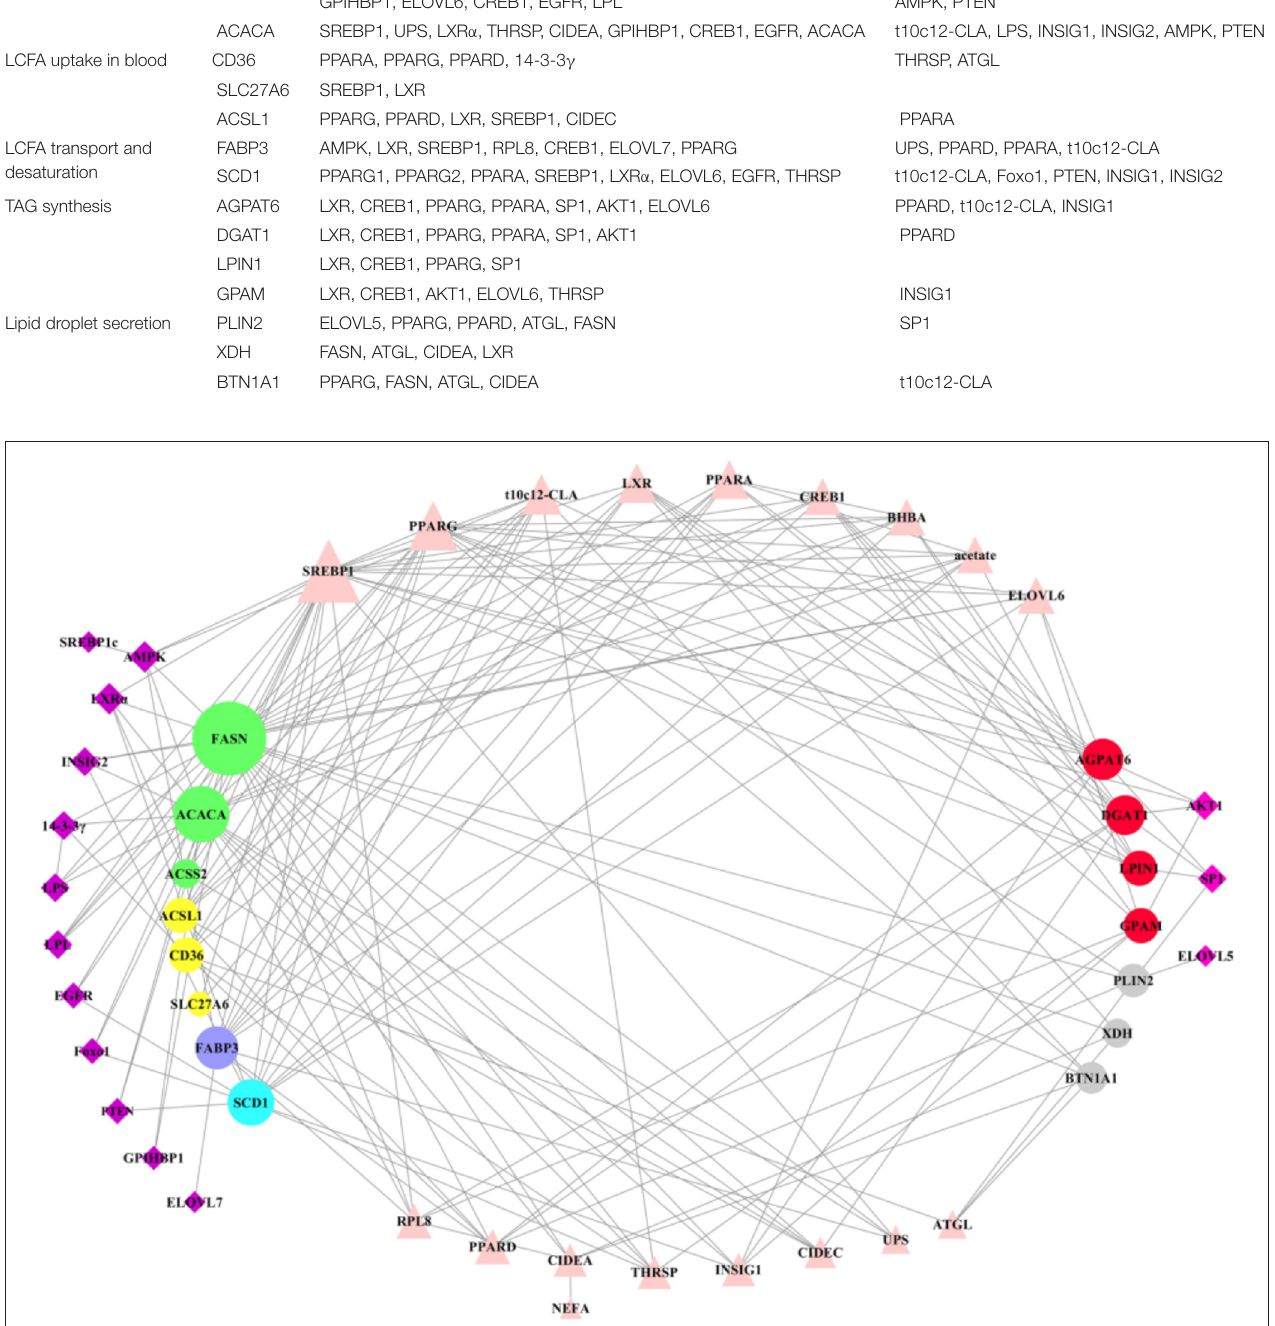
Frontiers in Nutrition |